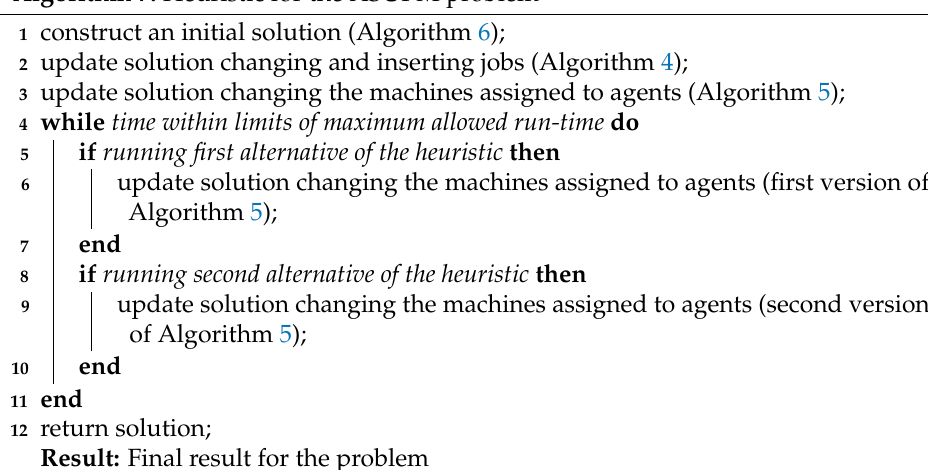
Algorithm 7: Heuristic for the ASUPM problem